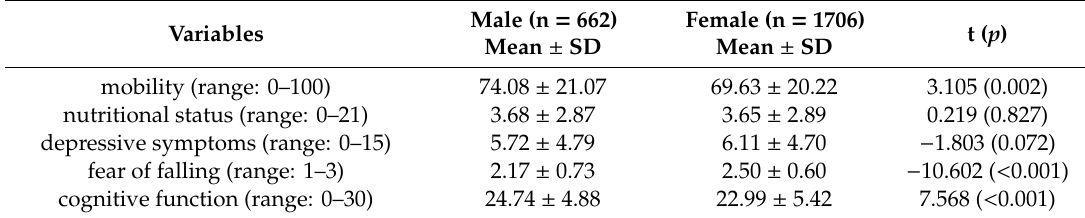
Table 2. Sex di ff erences in mean scores of study variables of older people in the prefrailty phase (n =